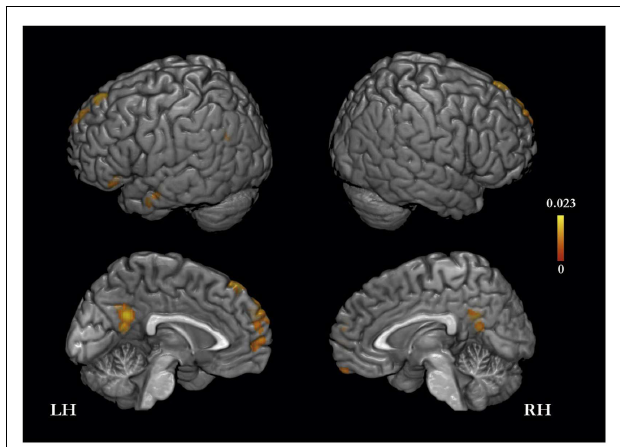
FIGURE 2 | Meta-analysis of activation foci (114 foci; 12 experiments) for other-traits compared with baseline .